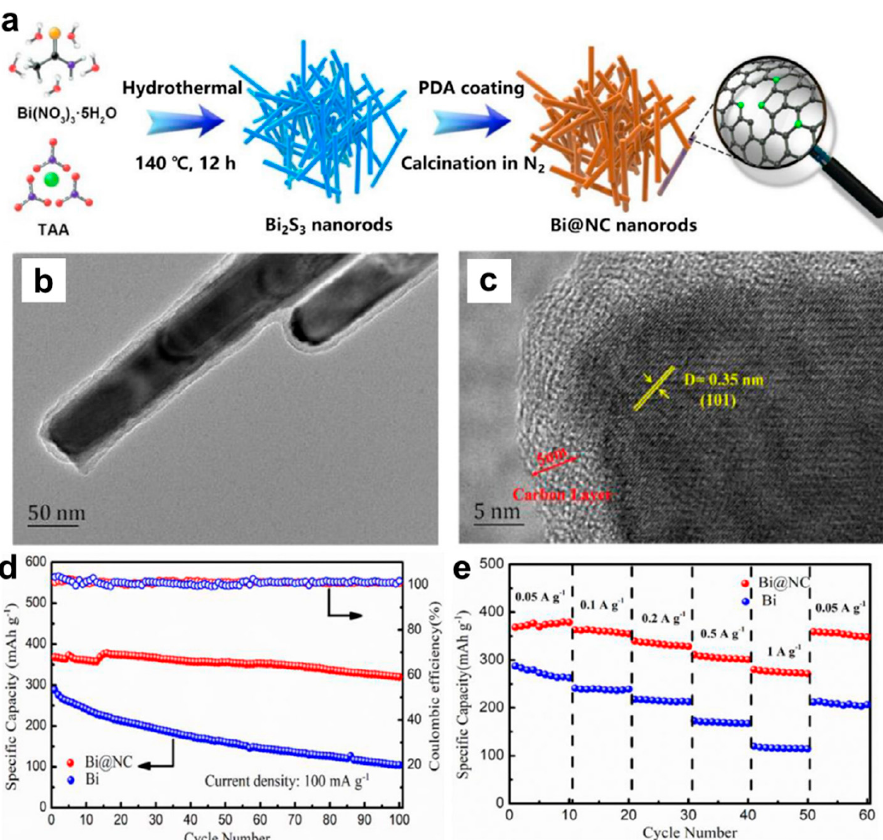
Figure 6. ( a ) Schematic illustration of the formation process of Bi@NC. ( b ) TEM and ( c ) HRTEM images of the Bi@NC. ( d ) Cycling stability and ( e ) rate performance of the Bi and Bi@NC electrodes. Reproduced with permission [33]. Copyright 2021, Elsevier B.V.